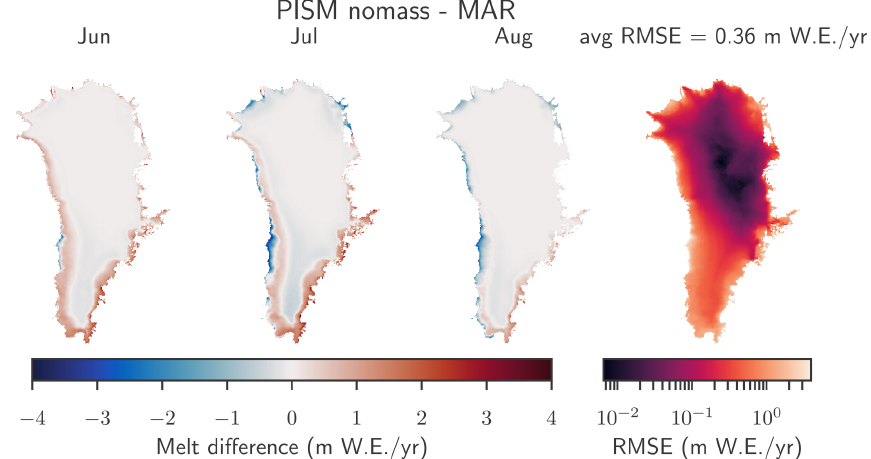
Figure 2. Local differences between the monthly averaged June, July, and August melt rates as diagnosed with PISM-dEBM-simple com- pared to MAR. The PISM simulation uses monthly 2D temperature fields from MAR as forcing and parameterizes albedo and shortwave downward radiation as detailed in Sect. 2.3.1 and 2.3.2. Positive numbers mean that PISM overestimates the melt, and negative numbers mean that PISM underestimates the melt. The local root-mean-square error averaged over June, July, and August from 1958–2019 is shown in the right plot. The spatial average of the RMSE is 0 . 36m/yr.